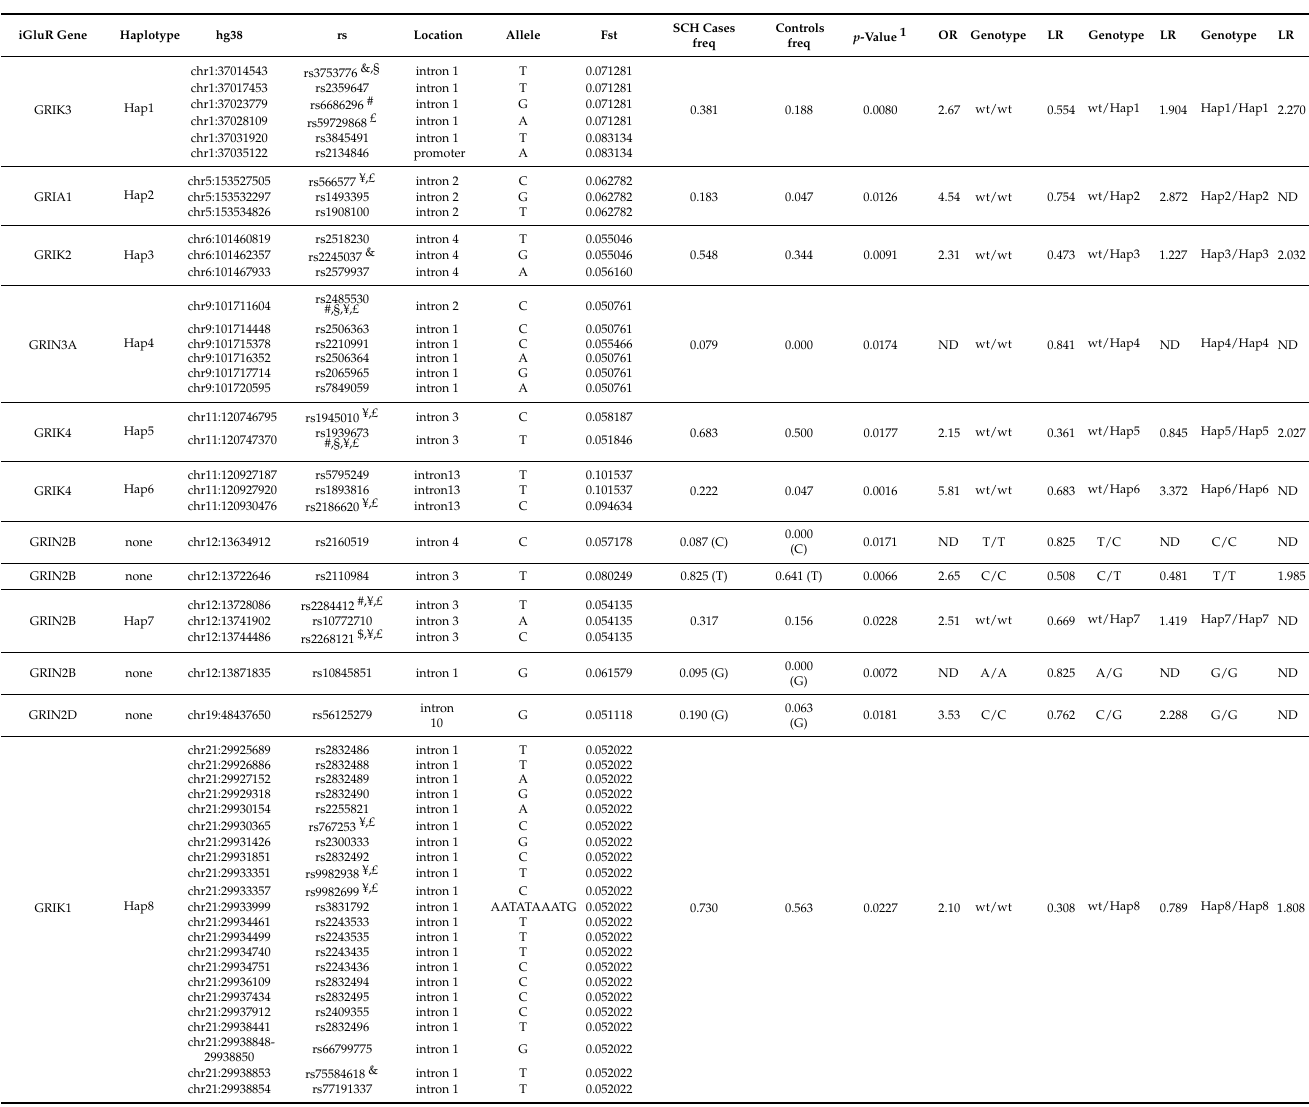
Table 4. Haplotypes and SNPs revealed using the Fst estimate. Each haplotype is characterized by its SNPs, location, frequency of risk allele in the SCH subjects and the controls, and the corresponding Fisher exact test’s p -value. When possible, the odds risk ratio (OR) was calculated for each haplotype, as well as the likelihood ratio (LR) for specific genotypes. The LR suggests an additive model of the risk allele effect for most haplotypes. Variants that exhibit high conservation or colocalize with some regulatory elements or transcription factor binding sites are shown with appropriate symbols and are considered as functional candidate variants. An additional four SNPs are listed and characterized based on their Fst estimate above